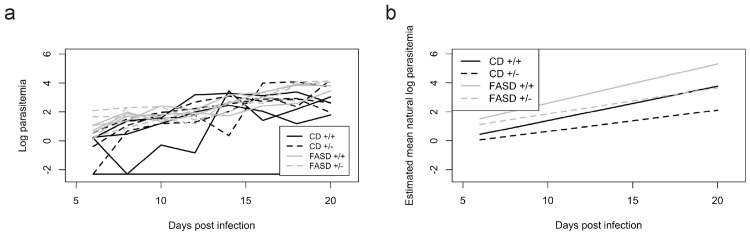
Parasitemia in CD and FASD mice.Parasitemia was measured every 48h from 6–20dpi. (a) Observed parasitemia trajectories from 5 randomly selected CD+/+ (n = 9), CD+/- (n = 14), FASD+/+ (n = 11), and FASD+/- (n = 12) mice from two combined experiments; selected trajectories are representative of the full data. (b) Statistical model showing estimated mean natural log of the parasitemia used to interpret parasitemia. The FASD mice had significantly higher overall levels of parasitemia than CD mice (p< 0.01, joint model of parasitemia and survival).